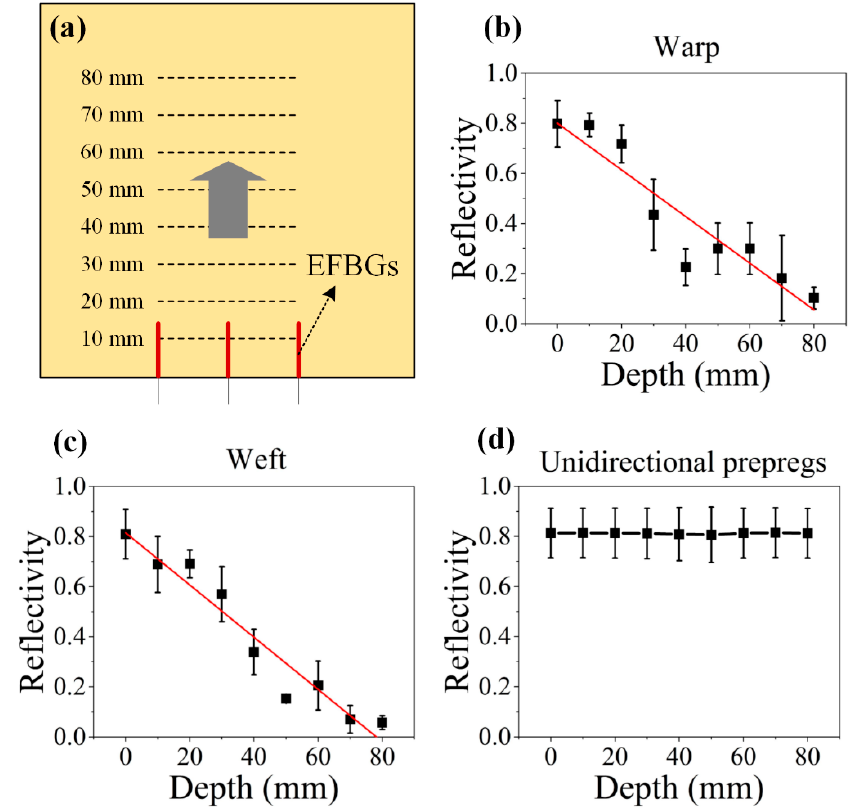
Figure 3. ( a ) Schematic diagram of the embedding test, and relation of reflectivity of EFBG sensors and the embedding depth ( b ) along fiber-reinforced thermoplastic polymer (FRTP) warp, ( c ) along FRTP weft, and ( d ) in unidirectional carbon/epoxy prepregs.